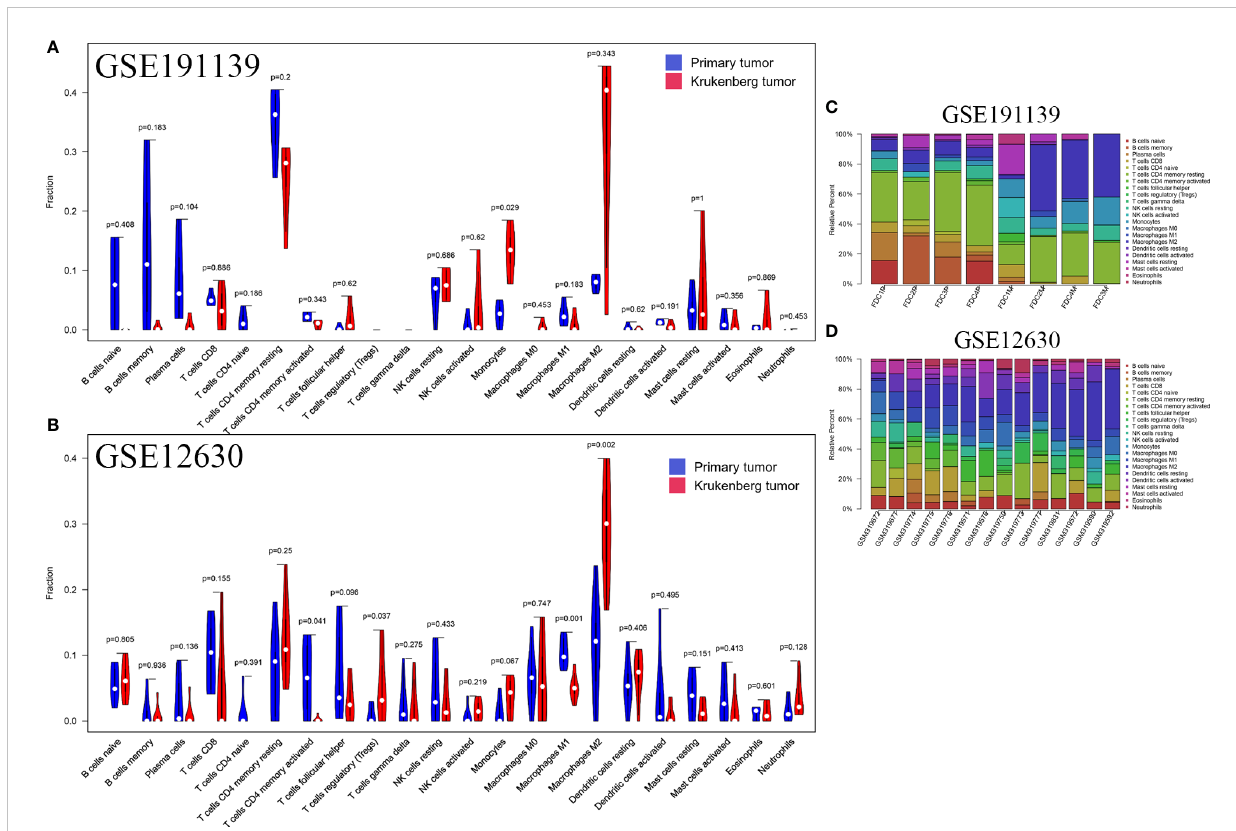
FIGURE 5 Relative proportion of 22 immune cells in primary tumors and KT tissues. (A) In the GSE191139 dataset, the numbers of M0 type macrophages (P = 0.453), M1 macrophages (P = 0.183), and M2 macrophages (P = 0.343) were similar in primary tumors and KT tissues. (B) In the GSE12630 dataset, M1 macrophages (P = 0.001) and M2 macrophages (P = 0.002) were more abundant in primary tumors than KT tissues, whereas no signi fi cant difference was observed in the number of M0 macrophages (P = 0.747). (C, D) Percentage of 22 types of immune cells in each